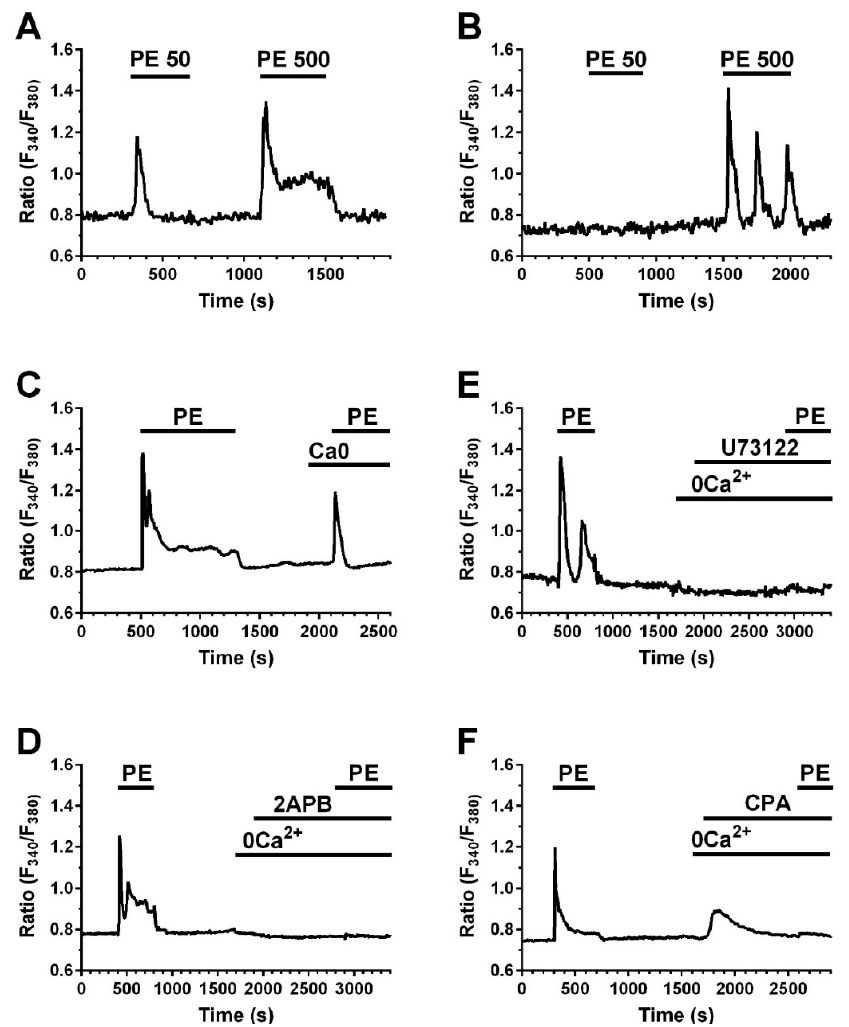
Figure 5 . Phosphatidylethanolamine (PE) induced Ca 2+ signals in normal human lung fibroblasts. ( A